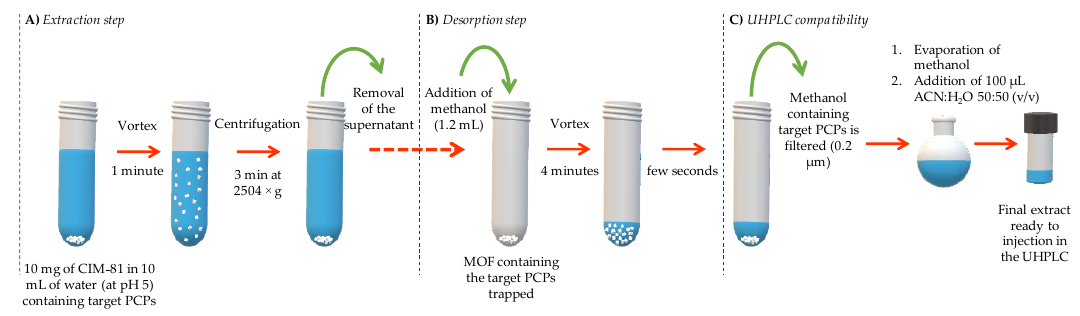
Figure 2. Scheme of the optimized D-µSPE-UHPLC-UV procedure using the CIM-81 MOF.